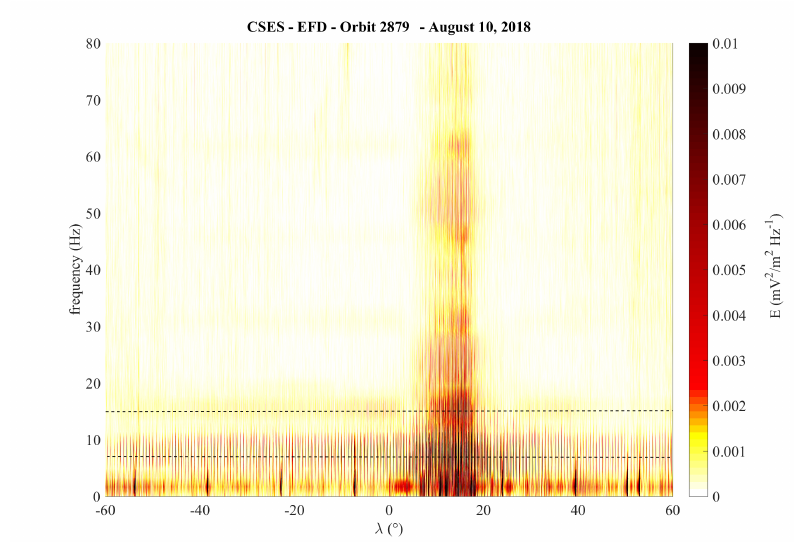
Figure 7. Spectrogram of electric field data in the frequency range between DC to 80 Hz for a nightside semi-orbit of the CSES satellite. Geographic latitude is given on the X-axis. The horizontal black dashed lines with peaks at about 7.8, and 15.0 Hz represents the detected Schumann